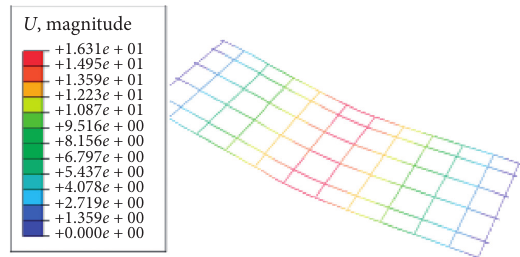
Figure 30: Cloud chart of the deformation of the rebar net under ultimate load.